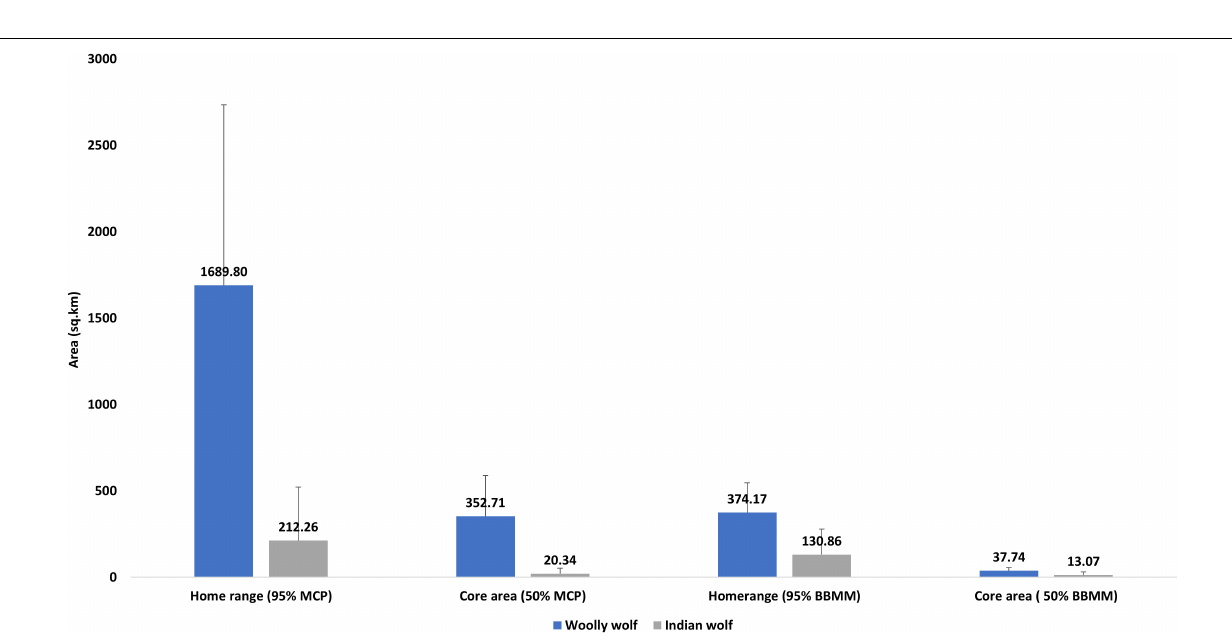
Frontiers in Ecology and Evolution |